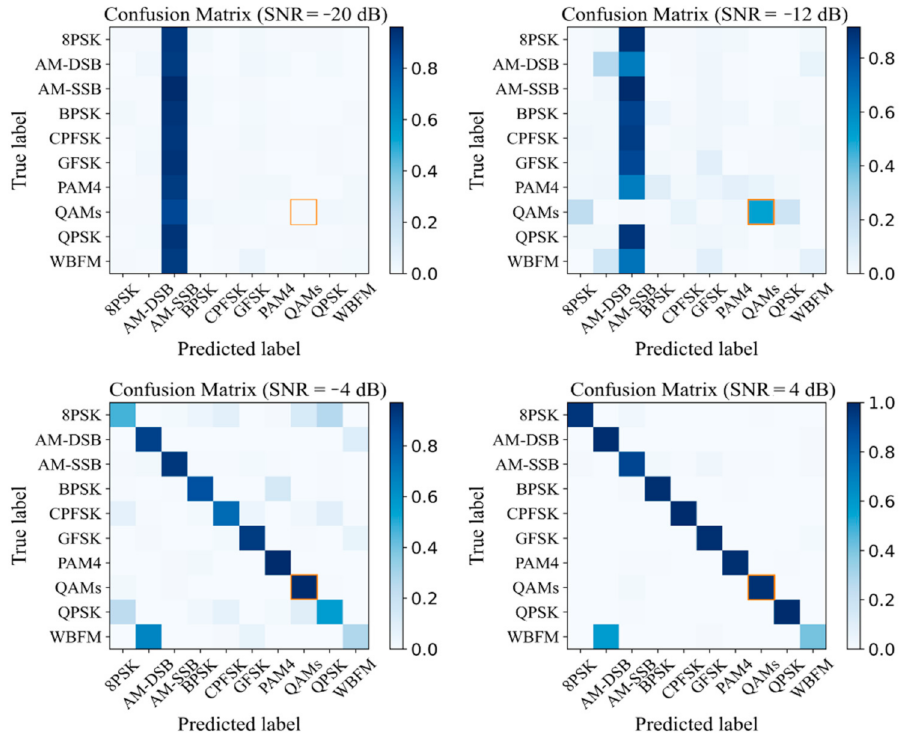
Figure 6. Confusion matrixes of IQCLNet at different SNR